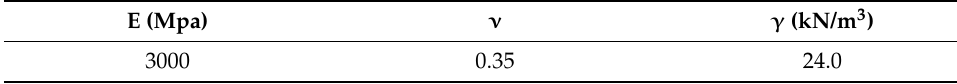
Table 2. Pavement parameters in the numerical analysis.